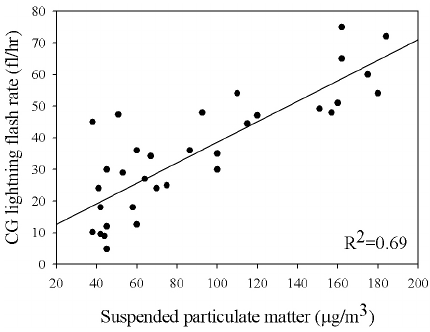
Figure 3. Scatterplot of the lightning flash rate and SPM over Taipei during premonsoon season.